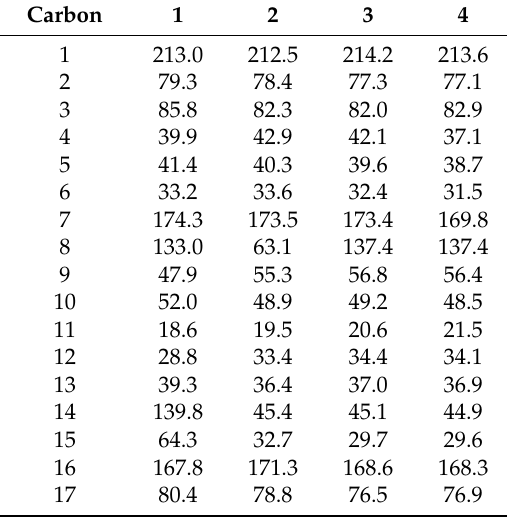
Table 2. 13 C-NMR (125 MHz) data of compounds 1 – 4 (CDCl 3 , δ C in